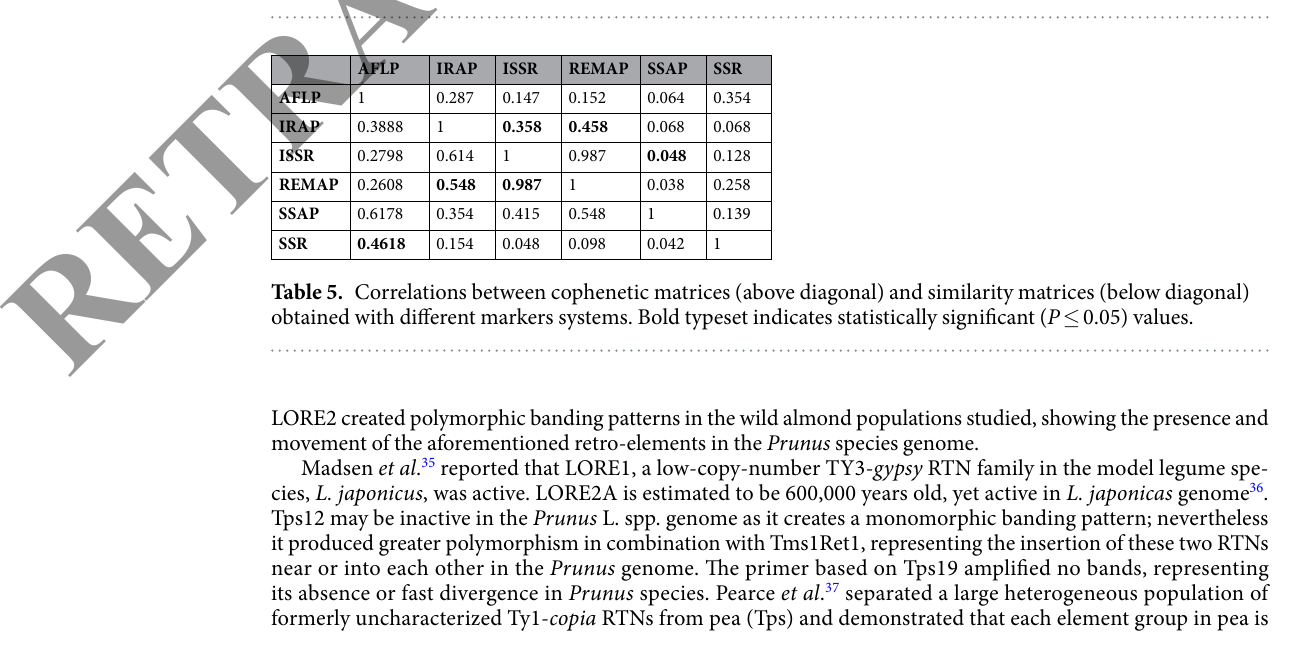
Figure 4. Observed pairwise differences and expected mismatch distribution. Observed pairwise differences (bars) and expected mismatch distribution (solid line) under the sudden expansion model for ( A ) the Euamygdalus section, ( B ) Spartioides section, and ( C ) Lycioides section calculated for all of marker data.